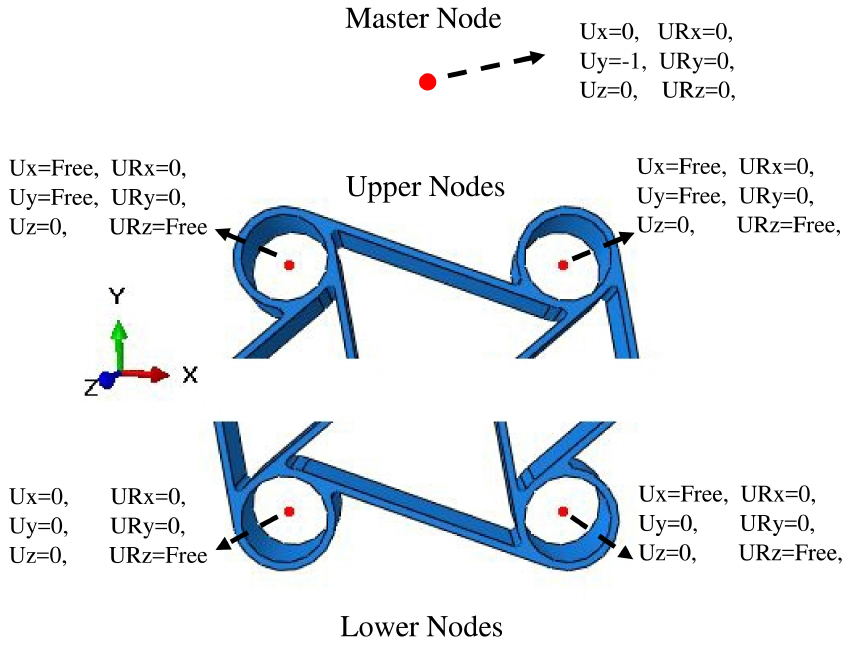
Figure 14. Boundary conditions of chiral units for cyclic